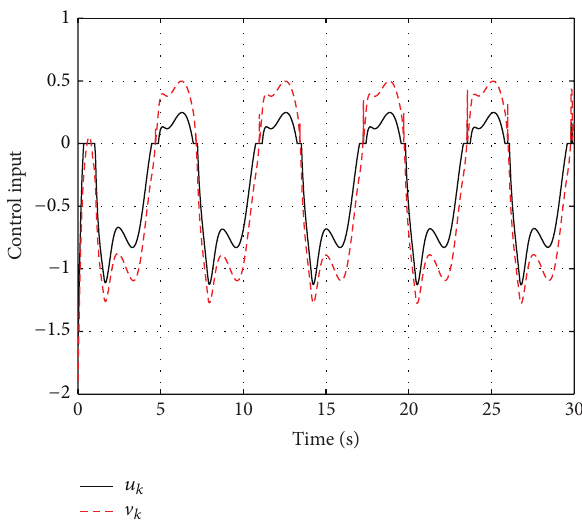
Figure 13: Control input 𝑢 𝑘 and V 𝑘 in Case 3.